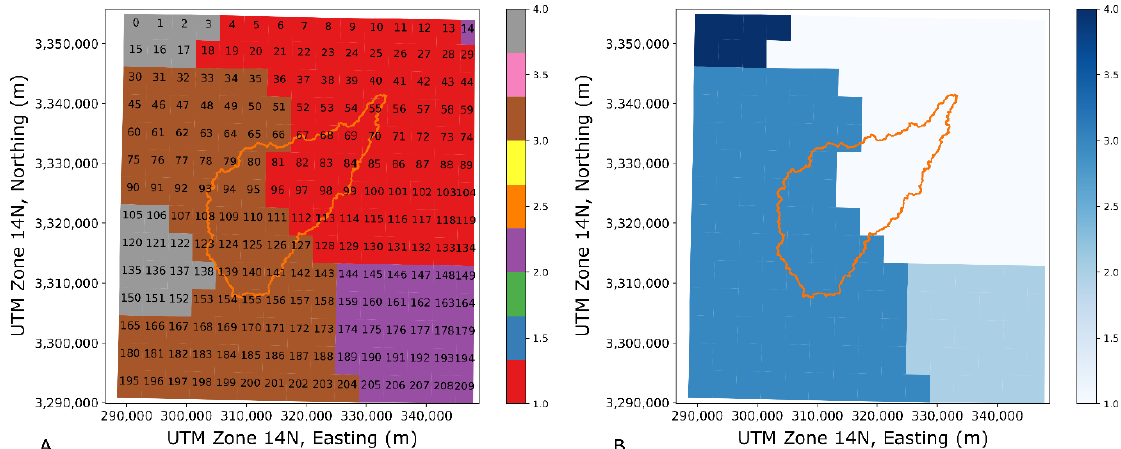
Figure A1. PRISM grid cell regionalization example for February 1981–2010. ( A ) K-Means clustering with four clusters was used to identify watershed regions. Point coordinates for clustering were three PCA-transformed variables from grid cell mean, median, variance, skewness, and kurtosis of daily precipitation depth. ( B ) A manual cleaning process was used to produce contiguous regions. Region labels were assigned so that 1 is northeast, 2 is southeast, 3 is southwest, and 4 is northwest. Grid cells were renumbered from 0–209 for the manual cleaning.